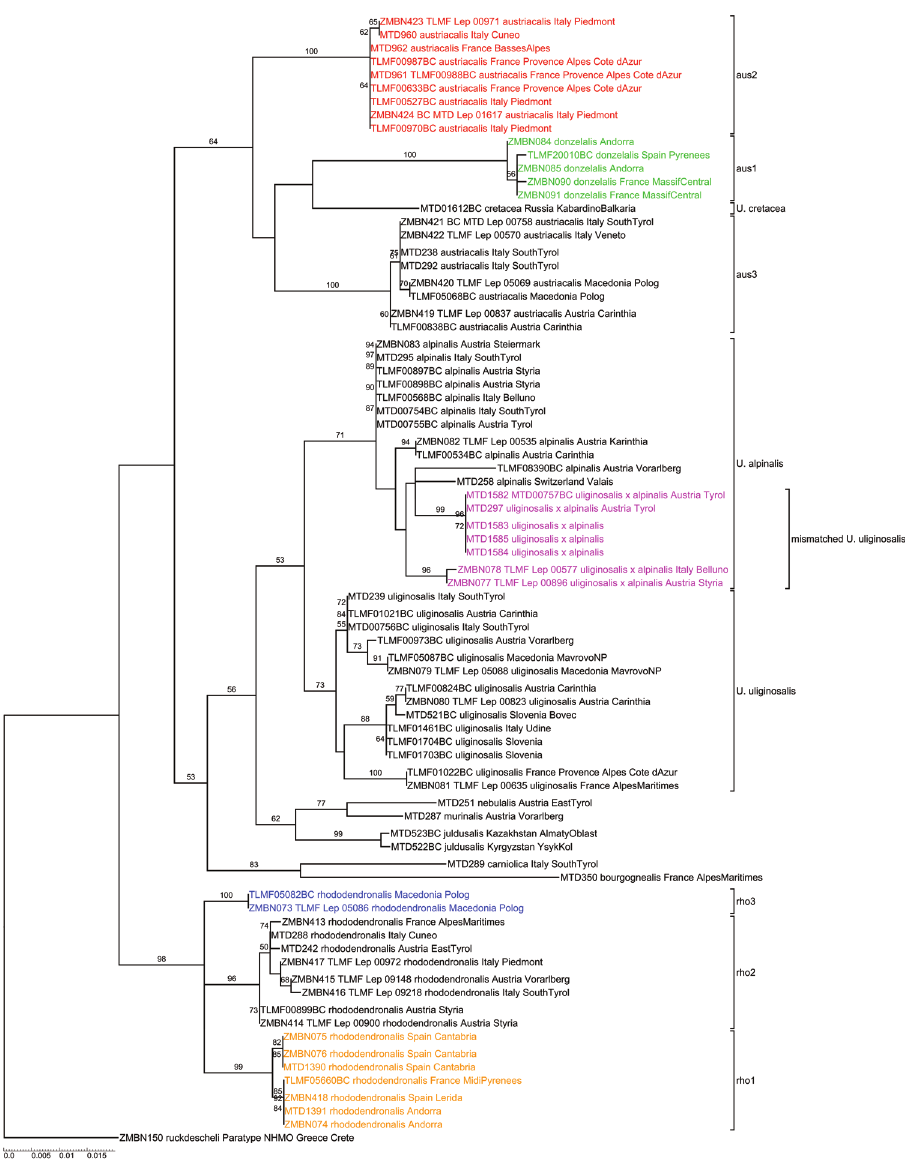
Figure 1. Maximum Likelihood analysis of COI Barcode data of the Udea alpinalis species group. Num- bers on branches represent bootstrap values of ≥ 50 % inferred from 1,000 replicates, scale bar represents substitutions per